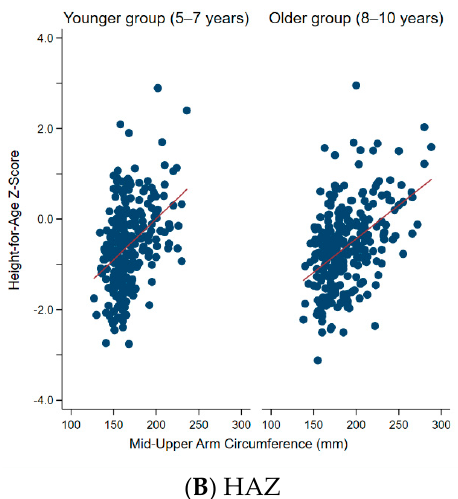
Figure 2. Distribution of mid-upper arm circumference by ( A ) BAZ and ( B ) HAZ, according to age group (5–7 years vs 8–10 years). ( A ) For BAZ, r = 0.87 and 0.89, for the younger and older group, respectively ( p < 0.001). ( B ) For HAZ, r = 0.37 and 0.42, for the younger and older group, respectively ( p < 0.001). Abbreviations: BAZ, body-mass-index-for-age z-score; HAZ, height-for-age z-score.